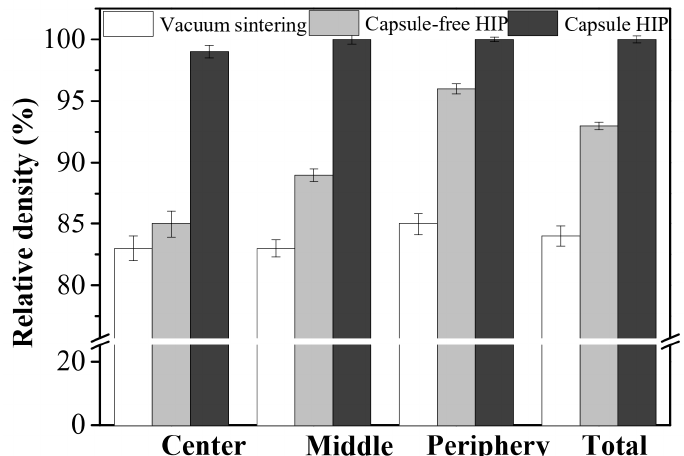
Figure 8. Relative density of Ti6Al4V alloy sintered by different sintering techniques versus different positions of the specimens.